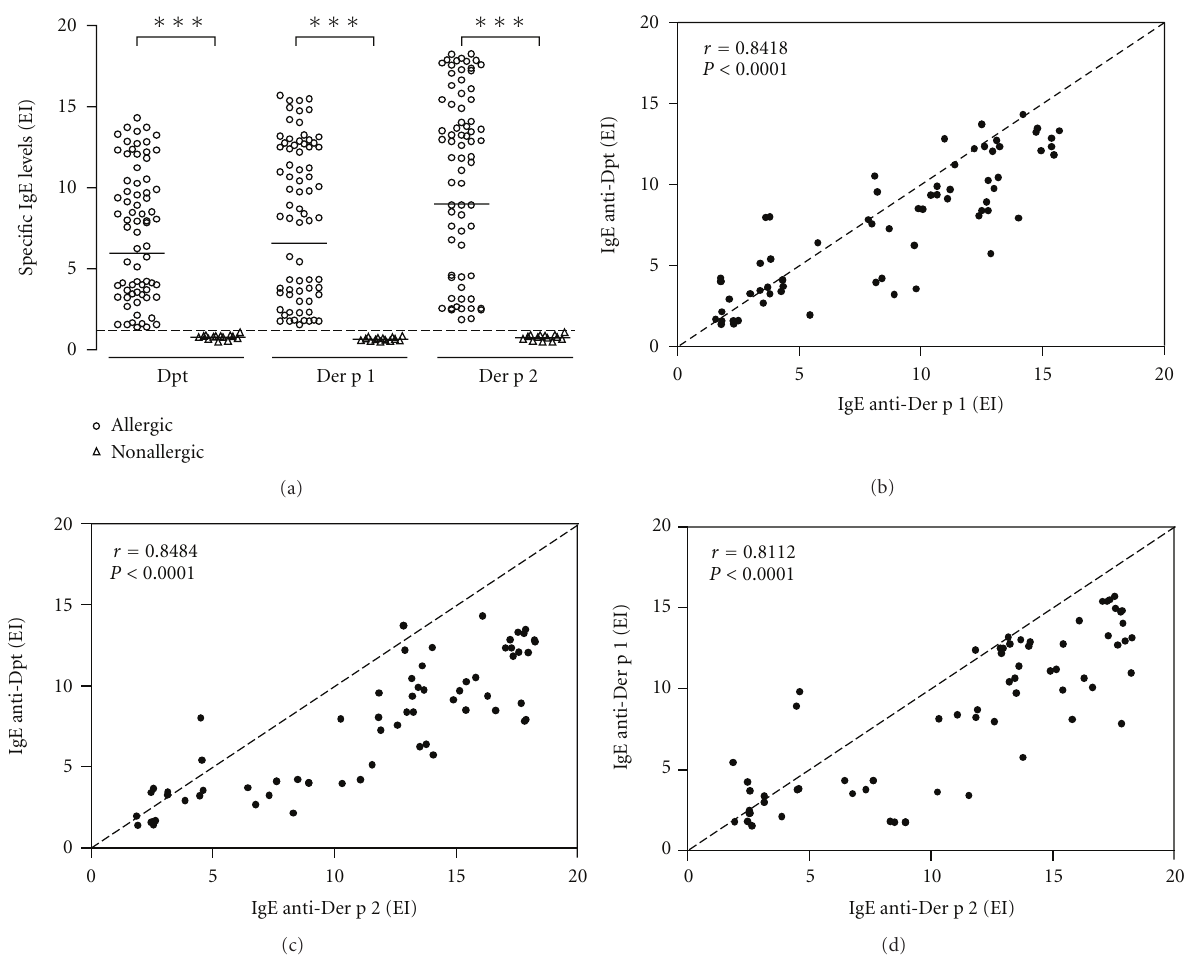
Figure 1: (a) Levels of IgE antibodies to Dermatophagoides pteronyssinus (Dpt) crude extract and its major allergens (Der p1 and Der p2) in serum samples from allergic ( n = 72) and nonallergic ( n = 14) infants. Data are expressed in ELISA index (EI) and the geometric mean for each allergen is indicated by horizontal bars. The dashed line indicates the cuto ff of the reaction (EI > 1 . 2). ∗∗∗ P < 0 . 0001 as determined by the Mann-Whitney U test. (b), (c), and (d) Correlation between levels of serum IgE anti-Dpt versus anti-Der p1 (b), IgE anti-Dpt versus anti-Der p2 (c), and IgE anti-Der p1 versus anti-Der p2 (d). The Spearman correlation coe ffi cient ( r ) and statistical significance are also